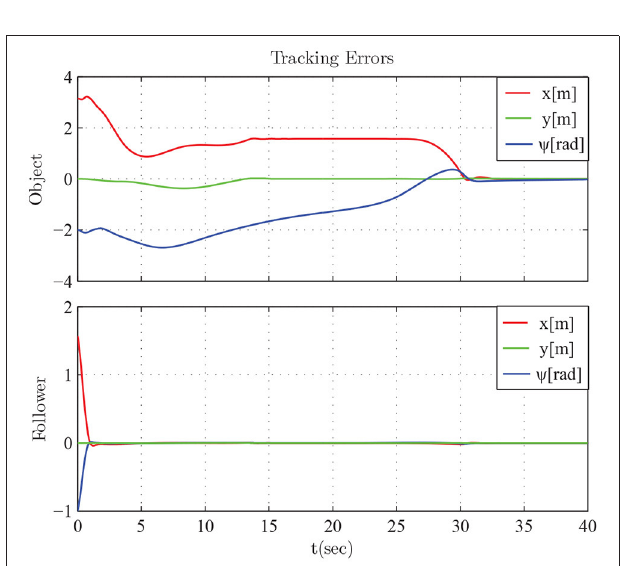
FIGURE 13 | The tracking errors.